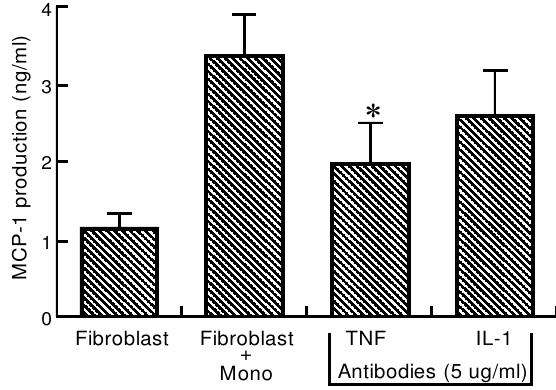
MIP-1 a was observed (Fig. 3). In contrast, when MCP-